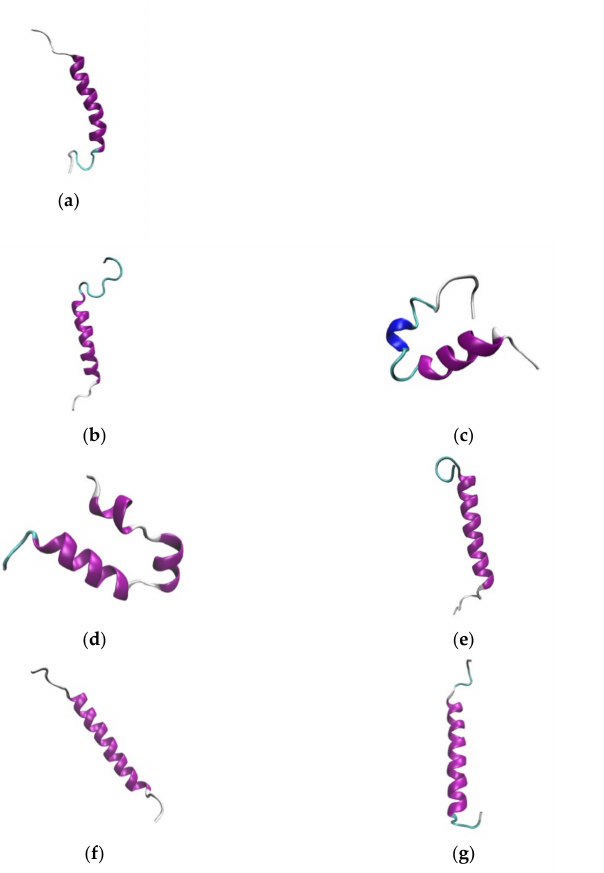
Figure 4. Snapshots of GLP-2 structure at 0 ns, 20 ns, 40 ns, 60 ns, 80 ns and 100 ns for different systems. Different colors correspond to different residues (available in VMD).